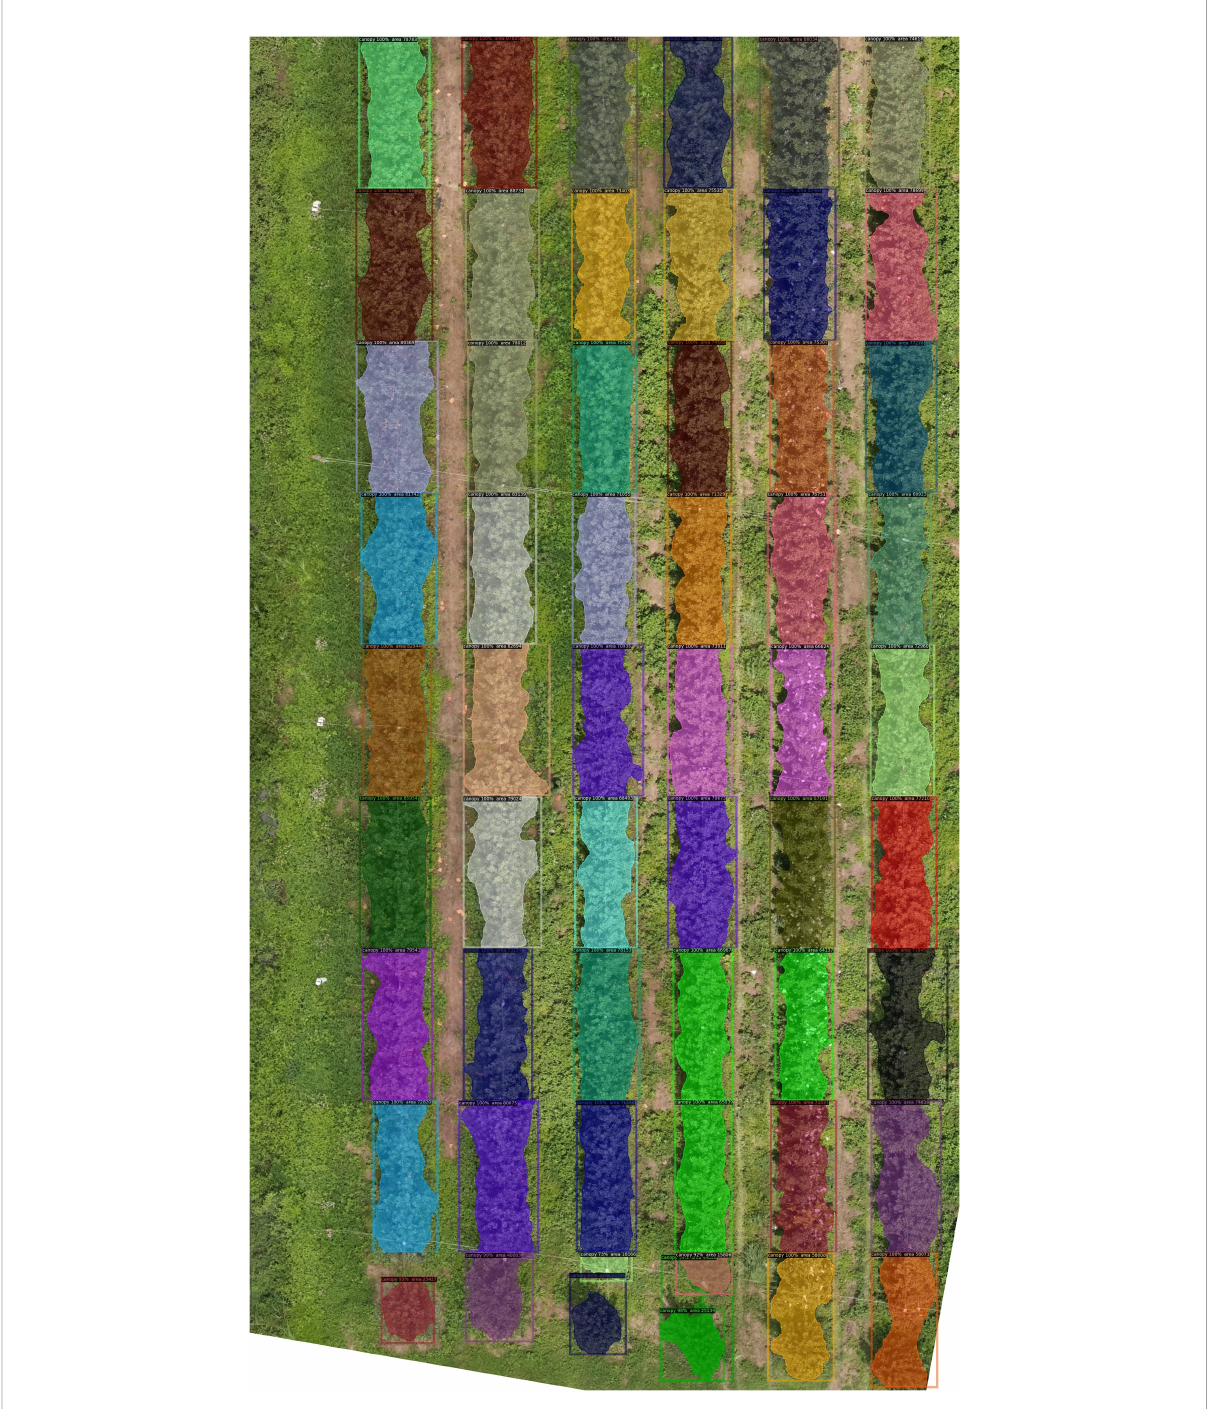
FIGURE 10 The visual results of stitching